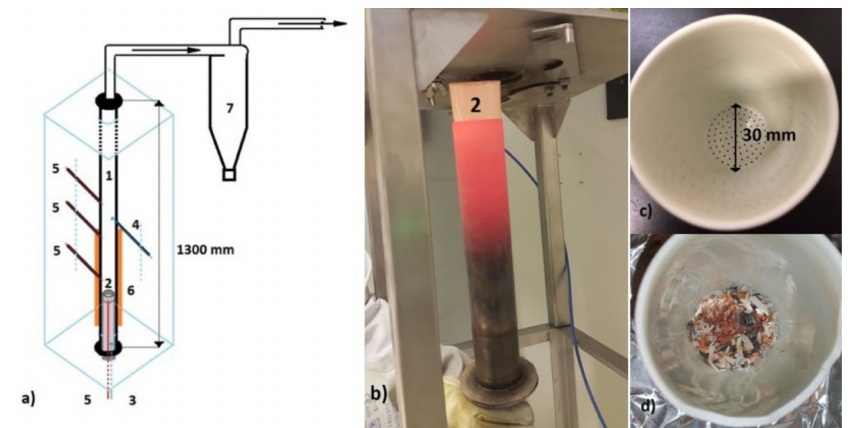
Figure 1. ( a ) Schematic view of the ENTECH fixed bed laboratory-scale reactor. 1: combustion chamber; 2: fixed bed; 3: primary air; 4: secondary air; 5: thermocouples; 6: heating zone; 7: cyclone; ( b ) hot fixed bed (2) withdrawn from the bottom of the reactor; ( c ) fixed bed (Gooch crucible) from above; and ( d ) fixed bed from above with